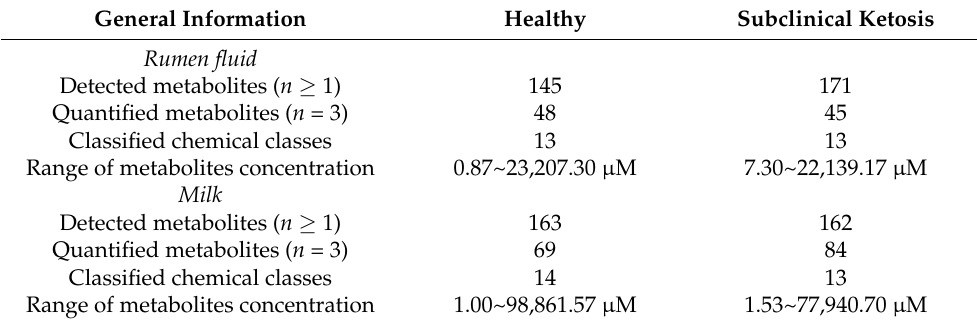
Table 2. Summary of general information of metabolites in rumen fluid and milk in experimental Holstein cows.